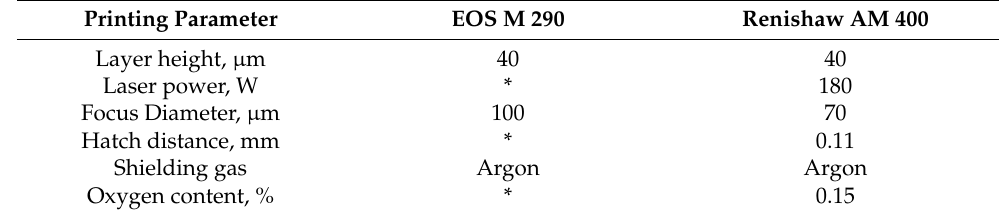
Table 4. SLM process parameters used on EOS M 290 and Renishaw AM 400 printer.